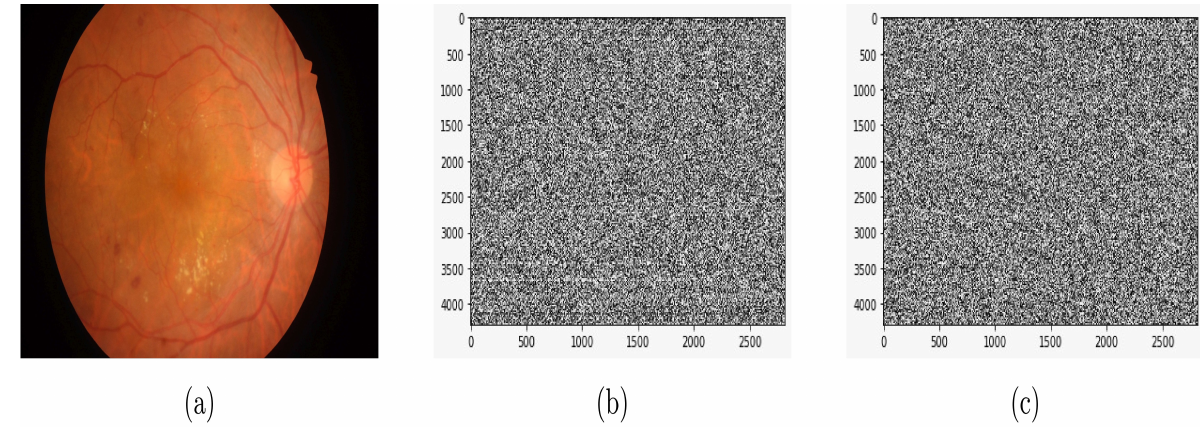
Figure 7. Image encryption steps: ( a ) Original Image, ( b ) The AES-GCM mask image, and ( c ) The encrypted image.